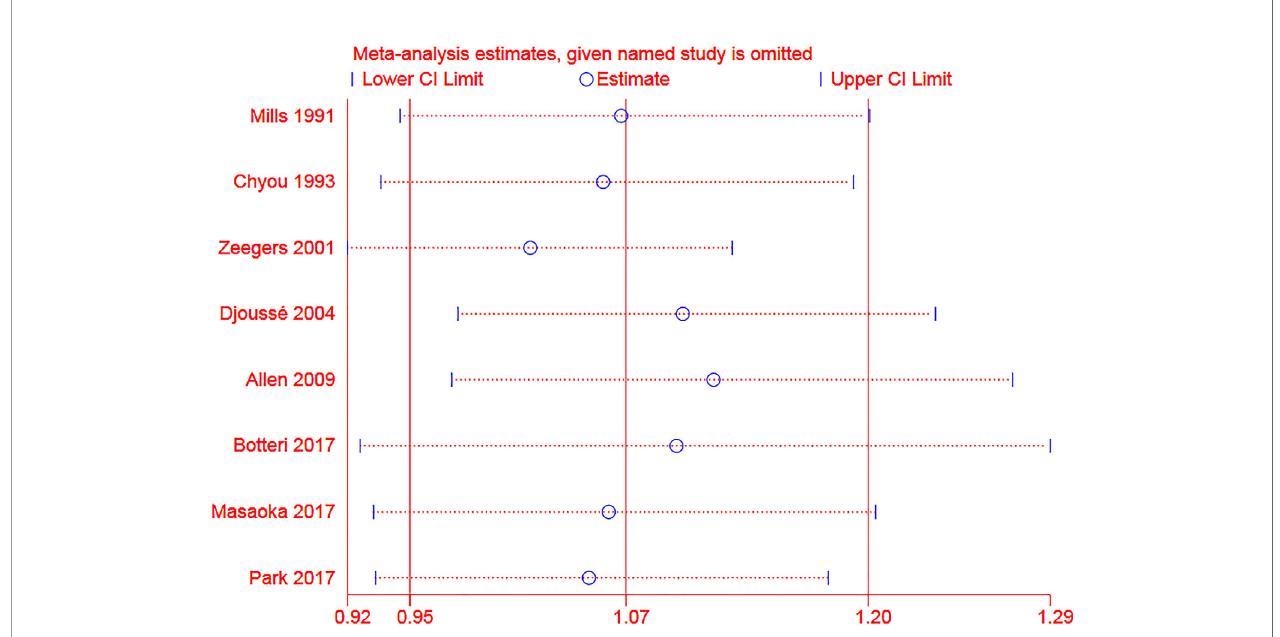
FIGURE 6 | Sensitivity analysis of the association between alcohol consumption (any vs none) and risk of bladder cancer (The two ends of the dotted lines represented the